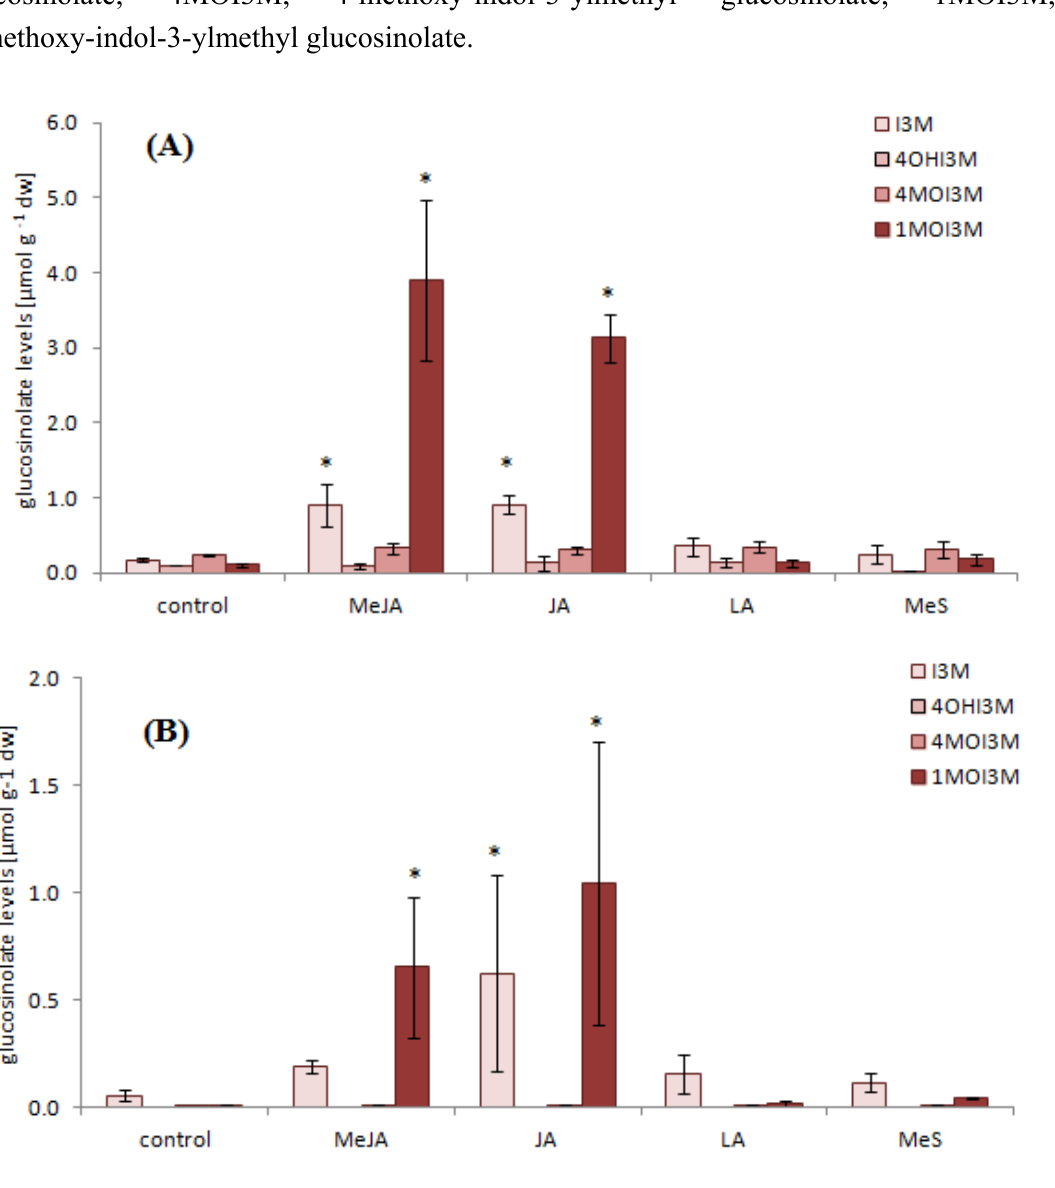
Figure 4. Individual indole glucosinolate levels in sprouts and mature leaves.Levels of indole glucosinolates shown as mean value with standard deviation ( n = 5) in µmol g − 1 dry weight of sprouts ( A ) and mature leaves ( B ) treated with signaling molecules: MeJA, methyl jasmonate; JA, jasmonic acid; LA, linolenic acid; MeS, methyl salicylate. *, treatment significantly different compared to control ( p ≤ 0.05, Dunnett